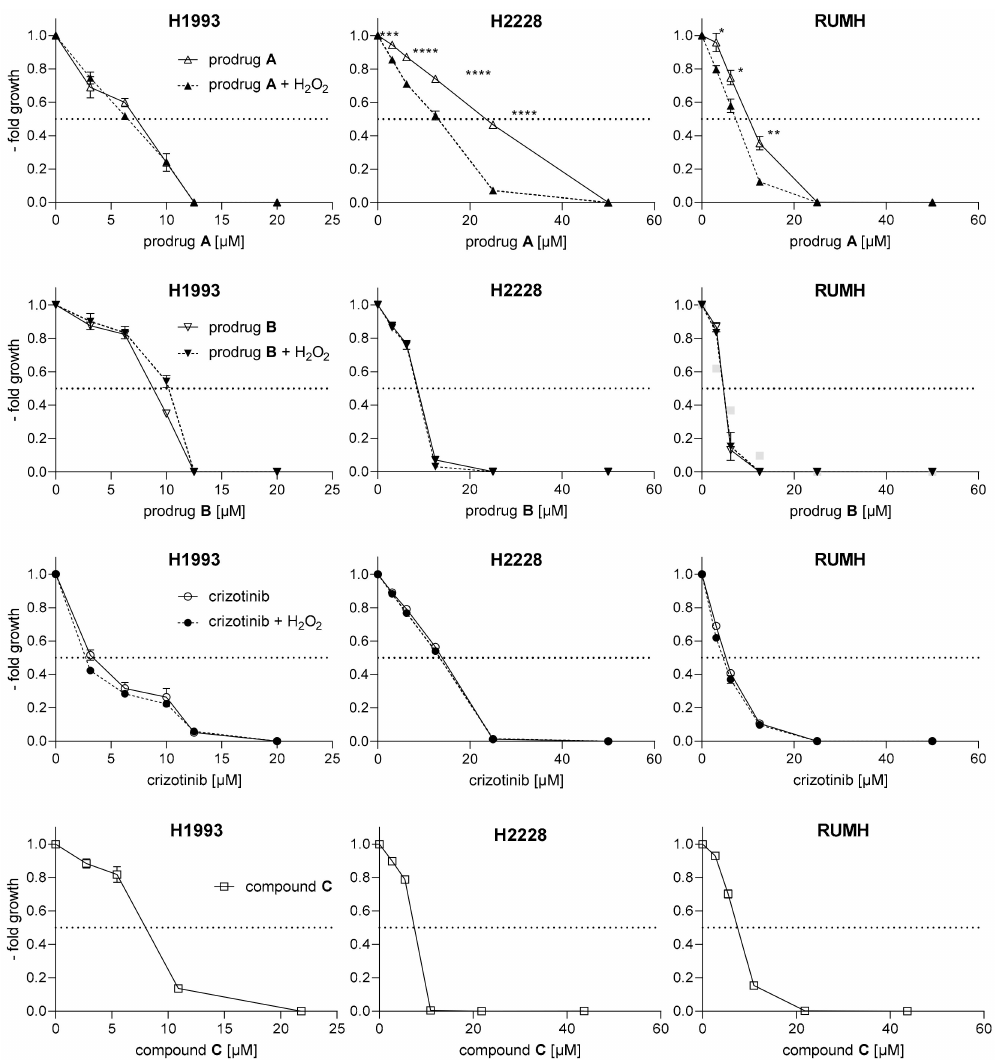
Figure 6. Anticancer activity of drugs − /+ H 2 O 2 pre-incubation in the three cancer cell lines H1993, H2228, and RUMH. Drug-induced cytotoxicity against the indicated cancer models was measured using MTT assay after 72 h of drug exposure. The values of the samples containing untreated cells were set to 1. Results are given as mean ± SD of triplicates from one representative experiment performed in triplicates. * p < 0.05, ** p < 0.01, *** p < 0.001, **** p < 0.0001 (multiple t